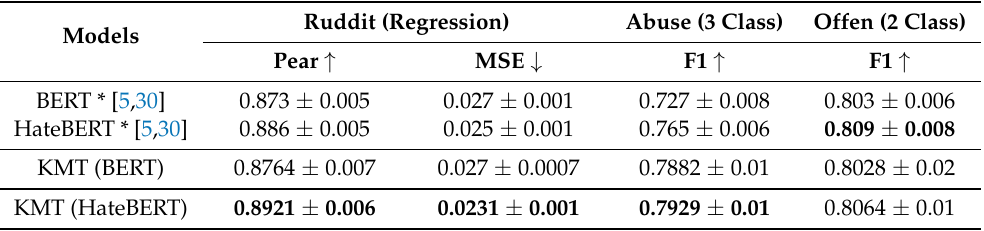
Table 2. Comparative results of KMT and existing methods. Superscript * indicates data obtained from the literature. The best results for each model are shown in boldface.